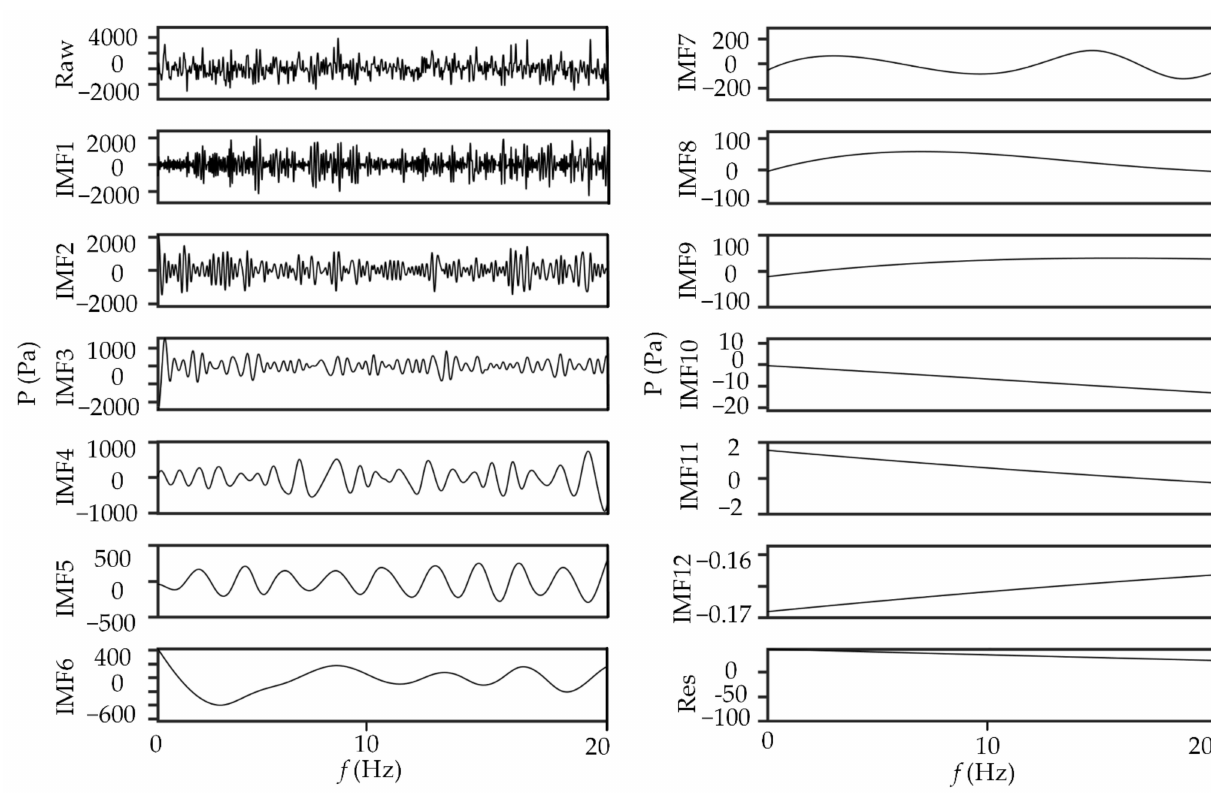
Figure 7. CEEMD decomposition